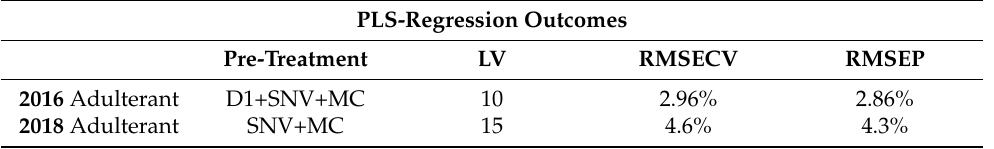
Table 2. Summary of PLS-R outcomes in terms of optimal pre-treatment (first derivative (D1), SNV, and MC), number of latent variables and root mean square error in cross -validation (RMSECV) and prediction (RMSEP).